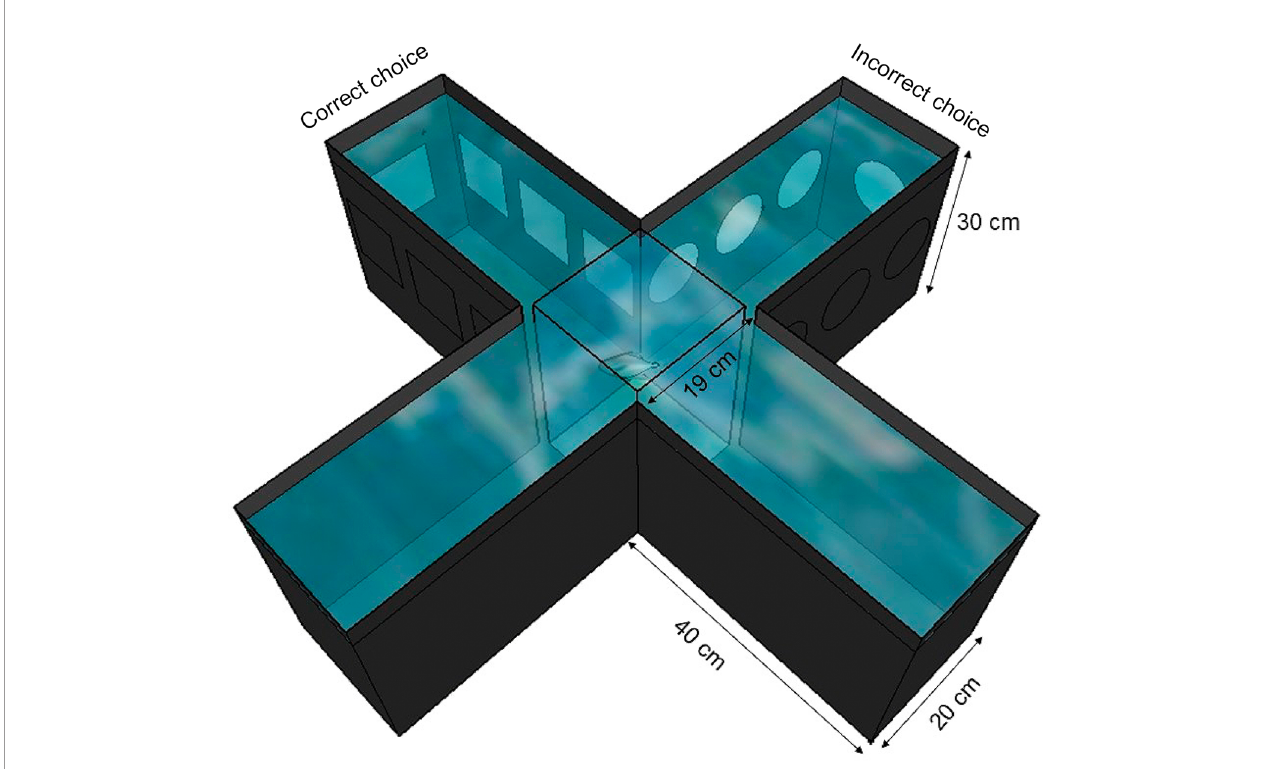
FIGURE 2 | Plus maze test aquarium used to assess learning and memory performance. Visual cues are exhibited on two arms of the apparatus, where squares indicate the right choice, and circles the wrong one. Three consecutive correct choices or 7 correct choices in 10 attempts ended the test and the animal was removed from the cross aquarium and returned to its original